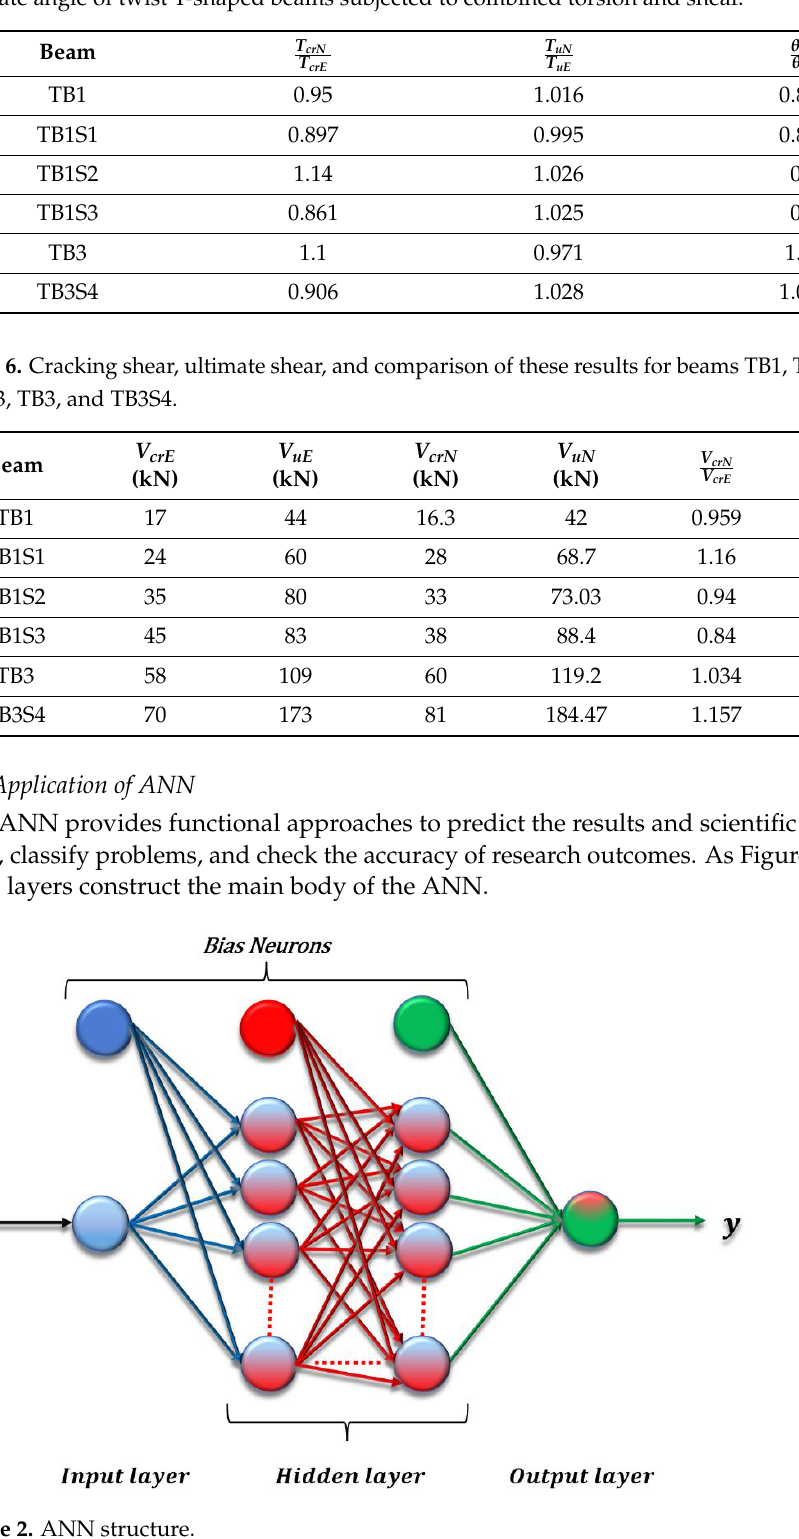
Table 5. Comparison of numerical and experimental values of cracking torque, ultimate torque and ultimate angle of twist T-shaped beams subjected to combined torsion and shear.